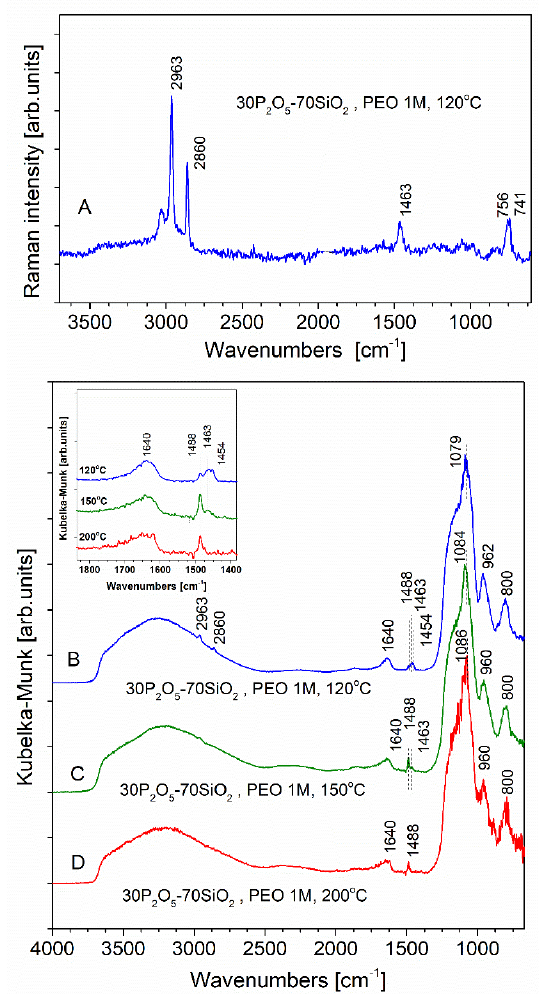
Figure 6. Raman scattering ( A ) and diffuse reflectance FTIR ( B – D ) spectra of 30P 2 O 5 -70SiO 2 glass modified by the addition of PEO M w = 10 6 g/mol. Spectra were recorded following sample annealing at 120 ( A , B ), 150 ( C ), and 200 °C ( D ).